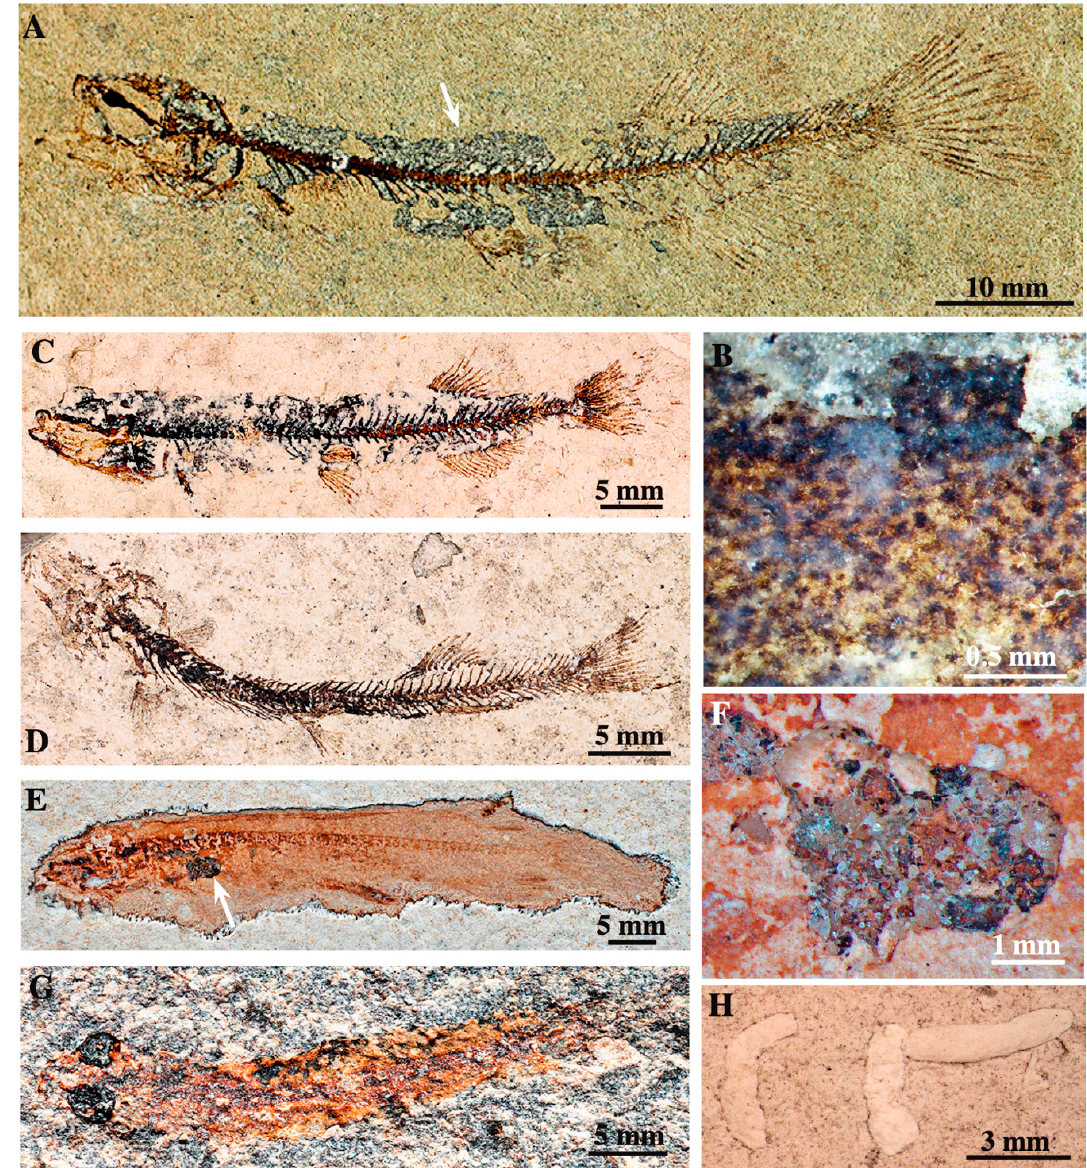
Figure 3. Foulden Maar, early Miocene, Galaxias e ff usus . ( A ), Articulated skeleton with skin partially preserved (OU22914); ( B ), Close-up of specimen A showing skin pattern with dark spots and blotches (photographed under ethanol); ( C ), Articulated, laterally compressed adult (OU22915); ( D ), Articulated adult with dorso-ventrally compressed head region (OU22916); ( E ), Juvenile Galaxias with body outline and gut contents (arrow) preserved (OU22698); ( F ), Close-up of specimen in E, showing gut content consisting of mineral grains, organic detritus, arthropod fragments and sponge spicules; ( G ), Galaxias larva prior to development of fins and skeleton (OU22697); ( H ), Three small coprolites produced by diatom-feeding Galaxias larvae.